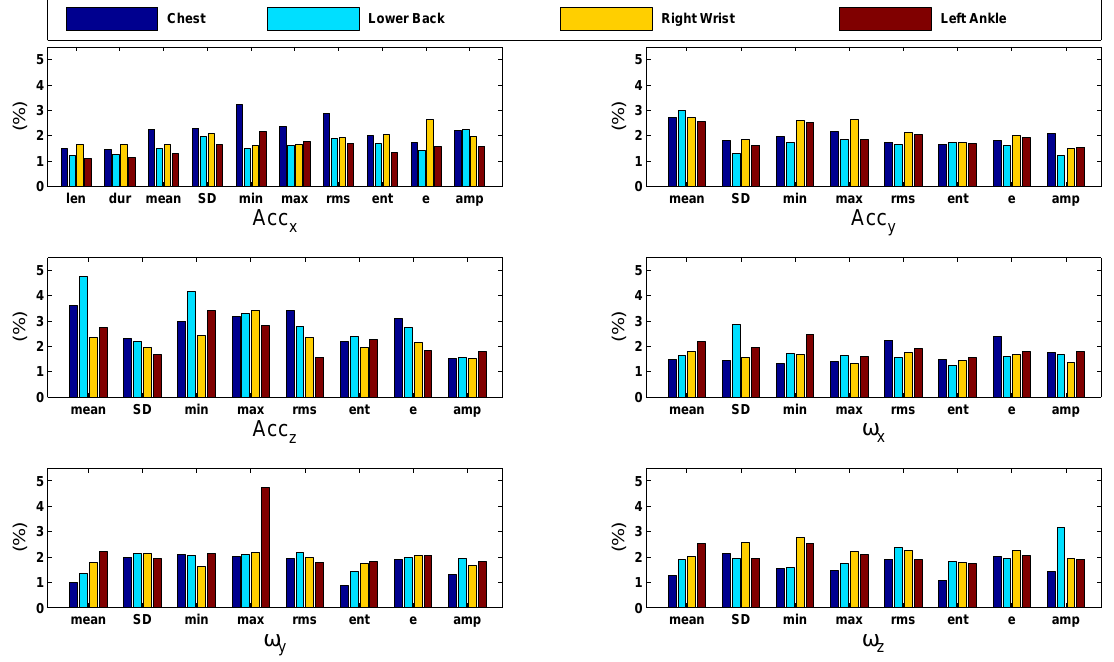
Figure 8. Bar graphs of the features’ importance computed during age classification using the 10-fold cross-validation strategy. The graphs present a comparison of the importance of each feature (in %) with respect to different sensor positions. In general, all features are significantly contributing in the classification